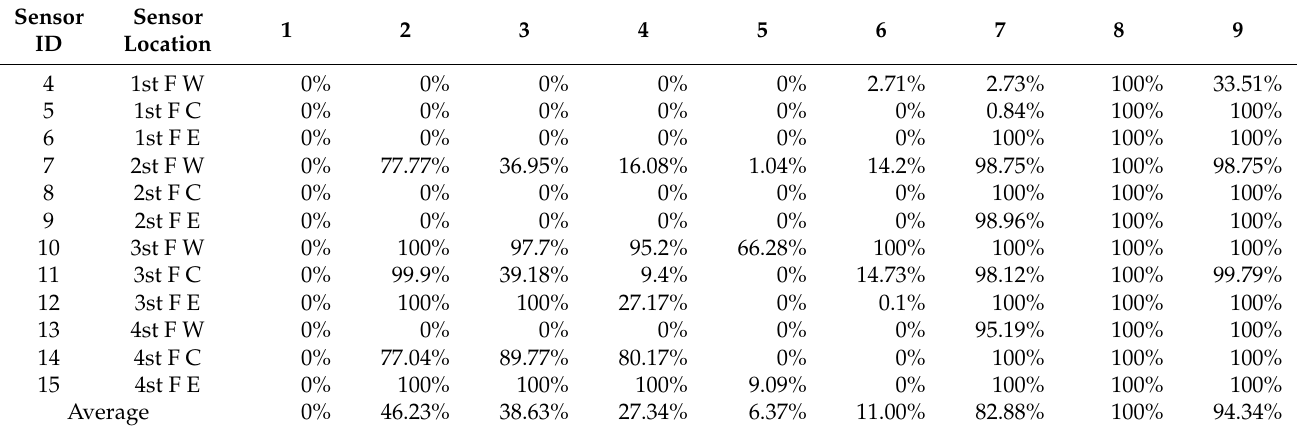
Table 4. Fault diagnosis results.